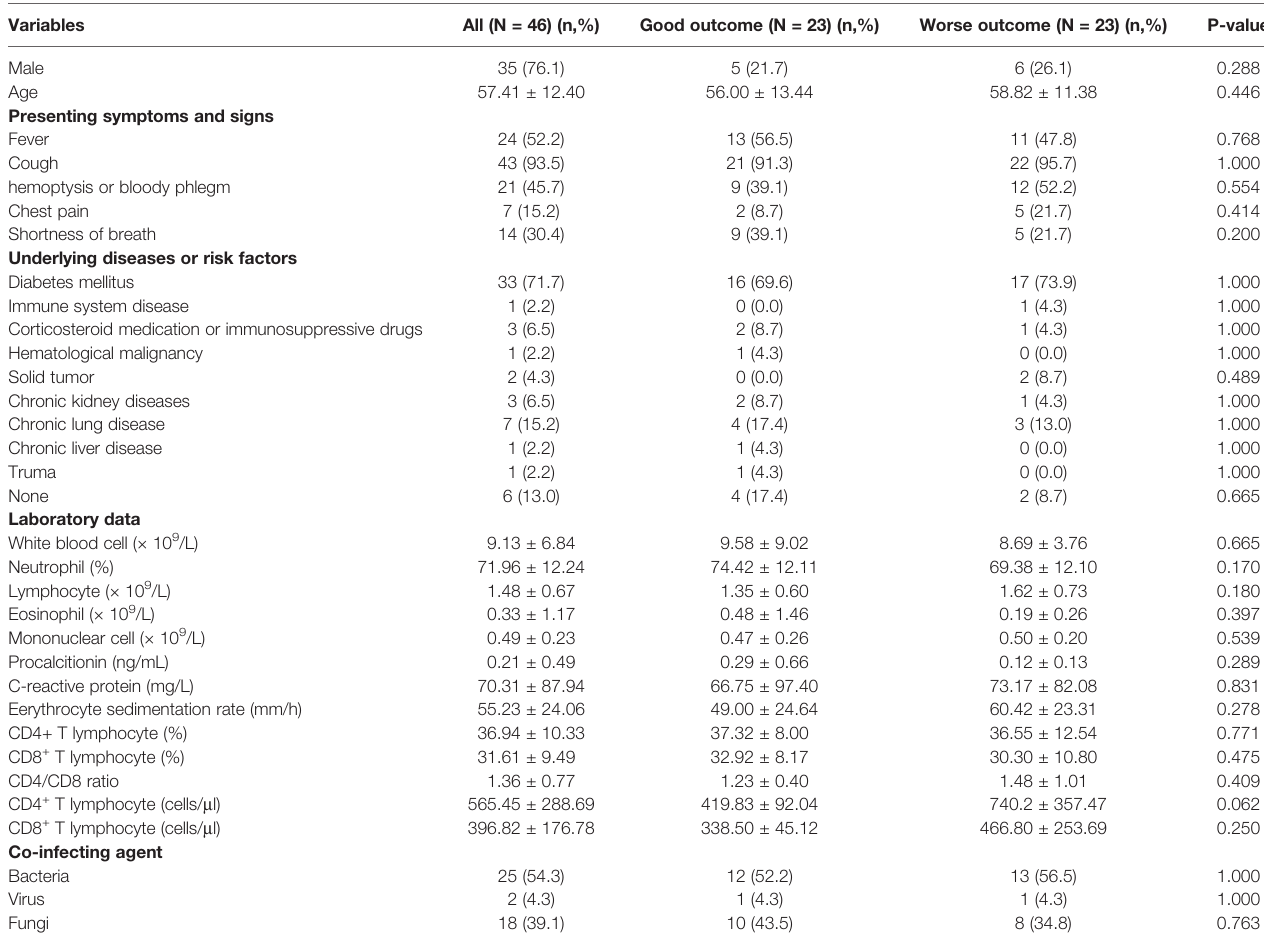
TABLE 2 | Demographic and clinical characteristics in patients with pulmonary mucormycosis. Variables All (N = 46) (n,%) Good outcome (N = 23) (n,%) Worse outcome (N = 23) (n,%)